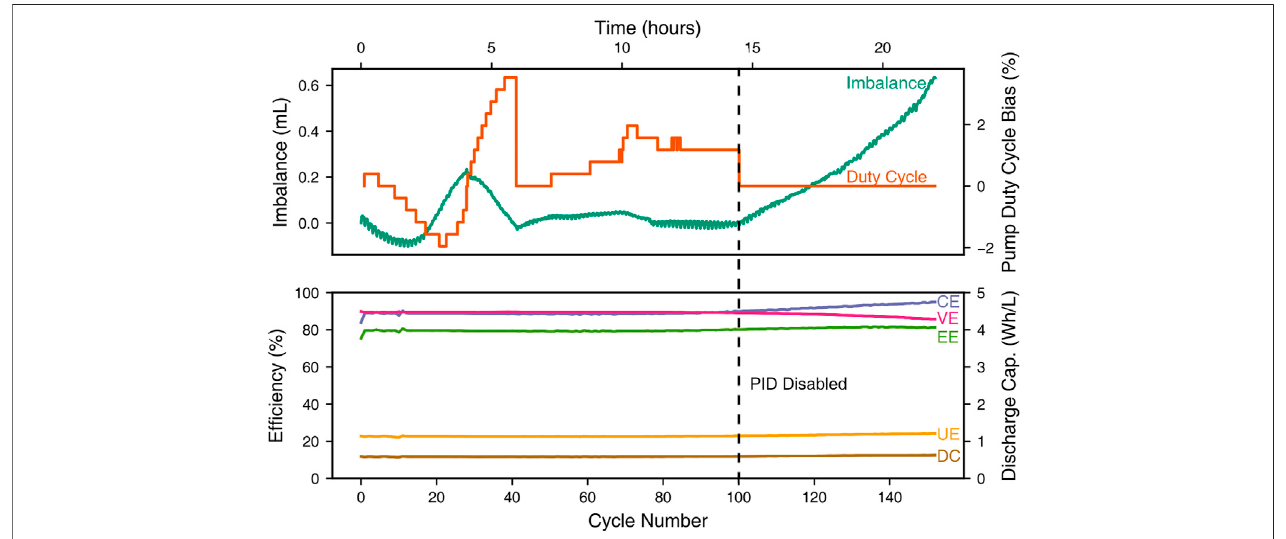
FIGURE2|Top: volumeimbalancebetweenthenominally5 mlelectrolytevolumesandPIDpump-speedoutputcontrolsignal,expressedasadutycyclebias,as functions of time while cycling. Bottom: Cycle ef fi ciencies (coulombic, CE; voltaic, VE; energy, EE; and utilization, UE) as well as discharge capacity (DC) as functions of cycle number.